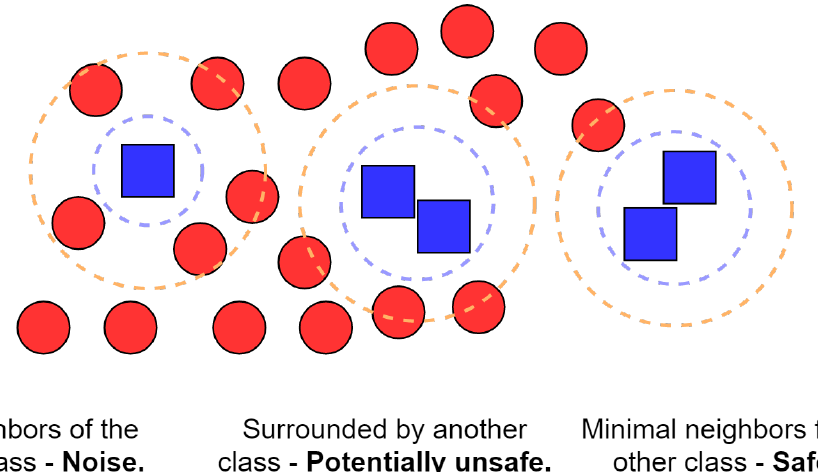
Figure 10. An illustration of the Synthetic Minority Oversampling Technique (SMOTE) algorithm in the case of 2 classes depicted by blue squares (minority class) and red circles (majority class). The blue square on the far left is isolated from other members of its class and is surrounded by members of the other class; this is considered to be a noise point. The cluster in the center contains several blue squares surrounded by members from the other class and thus is indicative of potentially unsafe points that are unlikely to be random noise. Finally, the cluster in the far right contains predominantly isolated blue squares. The algorithm will then generate new synthetic samples, prioritizing the safer regions.